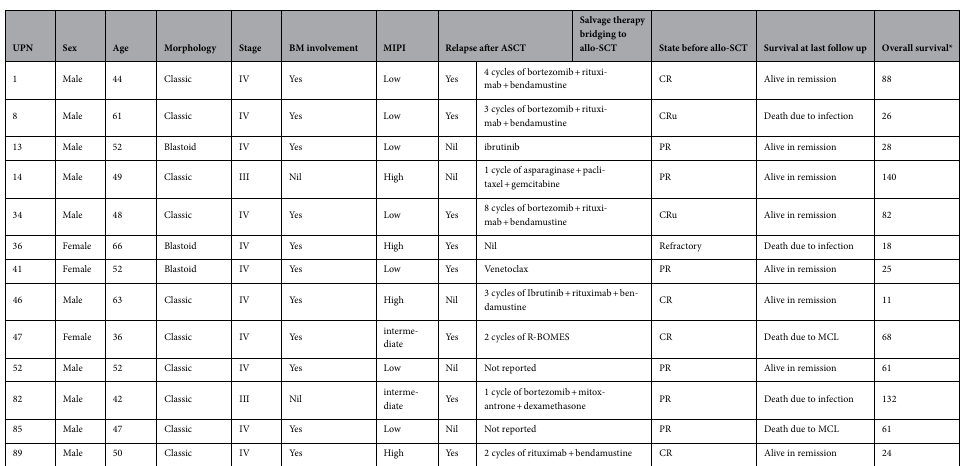
Table 2. Clinical characteristics of 13 mantle cell lymphoma patients who received allogeneic stem cell transplant. CR complete remission, Cru complete remission, unconfirmed, MIPI mantle cell lymphoma international prognostic index, PR partial remission, PD progression of disease, R-BOMES Rituximab, carmustine (BCNU), Vincristine, Methotrexate Etoposide, Methylprednisolone, UPN unlinked patient number.